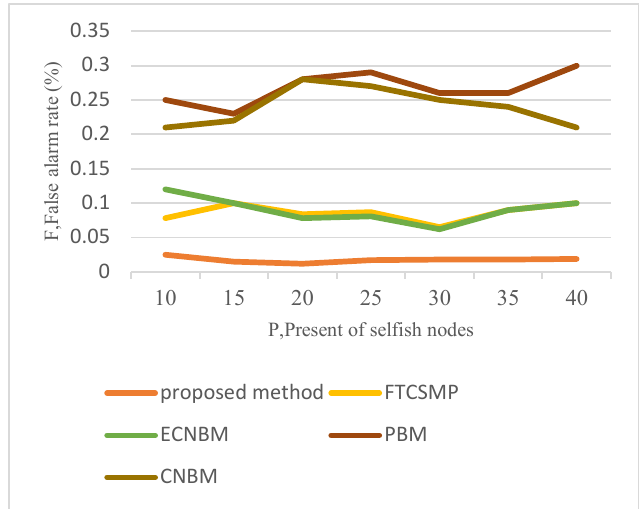
Fig. 6. False alarm